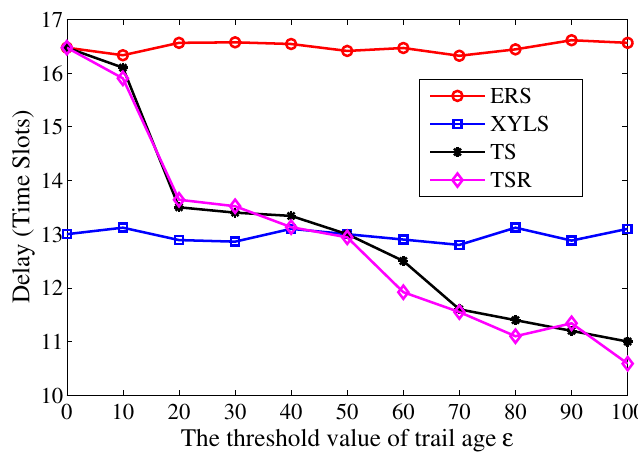
Figure 12. The search delay over the threshold value of trail age ε .